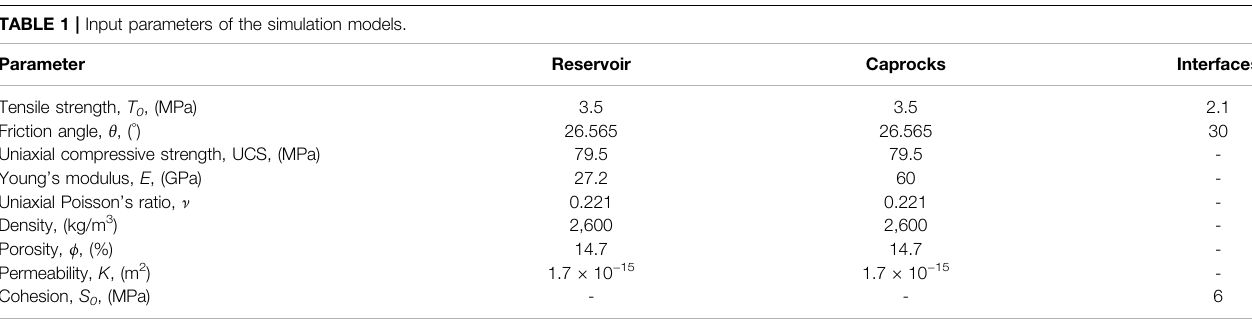
TABLE 1 | Input parameters of the simulation